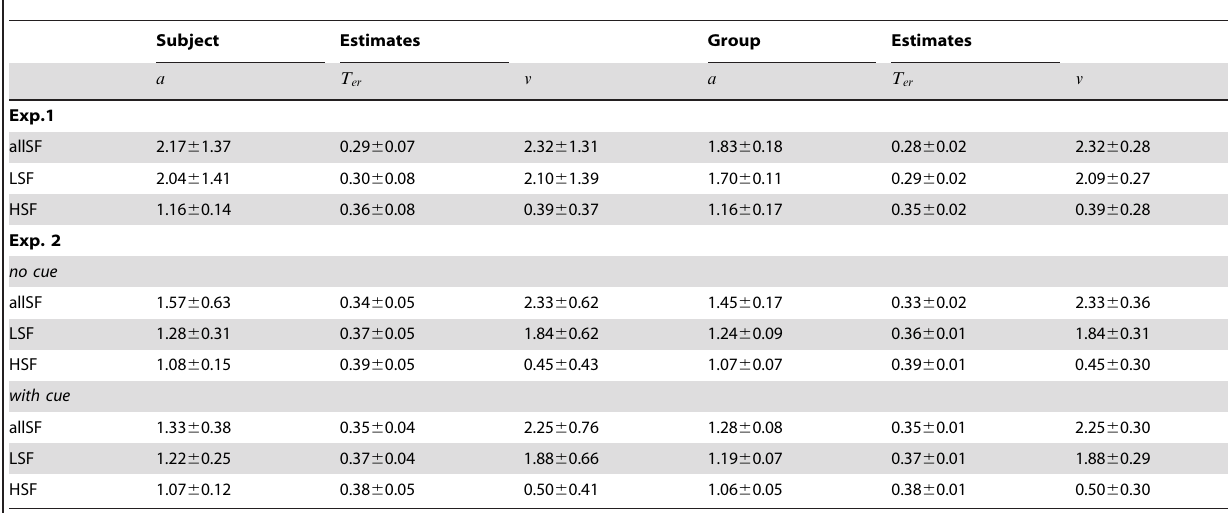
Table 2. Estimated HDDM parameters for all visual stop-task experiments